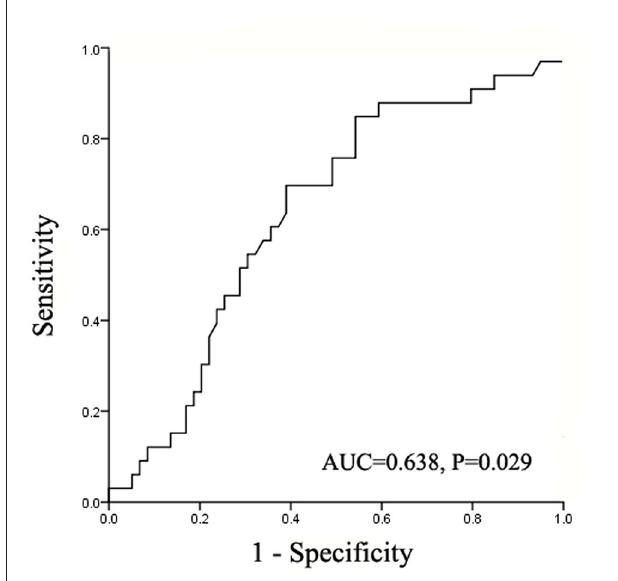
FIGURE 1 | The area under the ROC curve for postoperative complications determined using intraoperative total fluid infusion rate. ROC, receiver operating characteristic; AUC, area under the